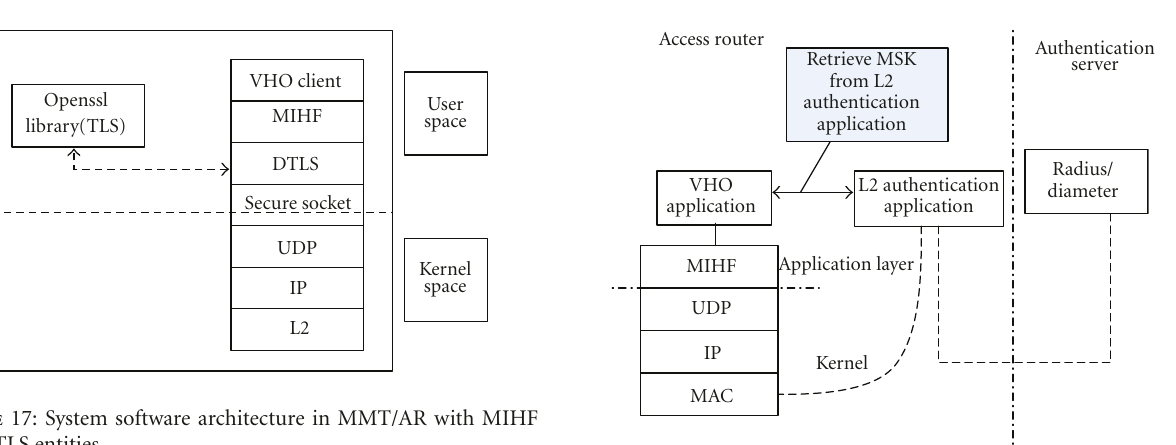
Figure 17: System software architecture in MMT/AR with MIHF and DTLS entities.